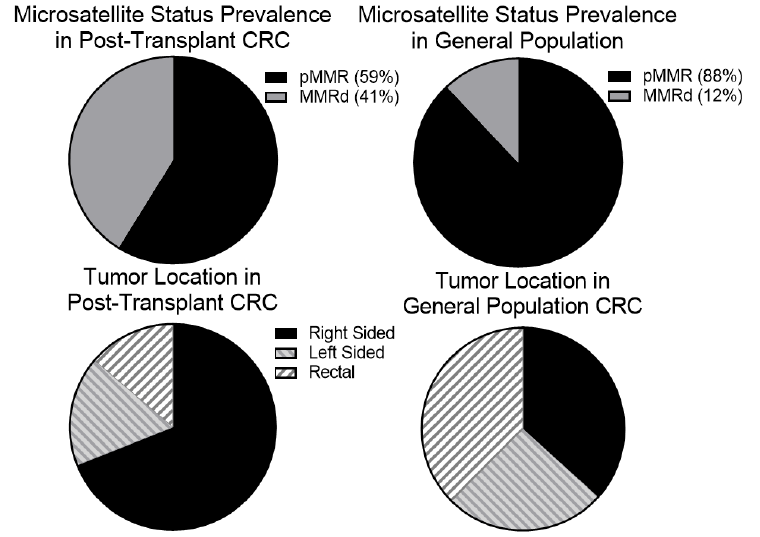
Figure 1. There is an increased proportion of mismatch repair deficient tumors and right-sided in the post-transplant population. We hypothesized that given the proposed role of the immune system in the reducing relapse risk in mismatch repair deficient tumors many of these immunogenic tumors may be cleared before becoming clinically apparent. We suspected, therefore, that an increased proportion of tumors that developed in post-transplant patients would be mismatch repair deficient (MMRd). To test this, we identified 17 post-transplant CRC patients that with tumor mismatch repair testing. Of these, 7 (41%) were MMRd which is higher than the general population. Right-sided tumors also show higher degrees of tumor infiltrating lymphocytes suggesting that they may be better recognized by the immune system. We noted that our post-transplant population had a higher rate of right-sided tumors (20/29 or 69%) than the general population.